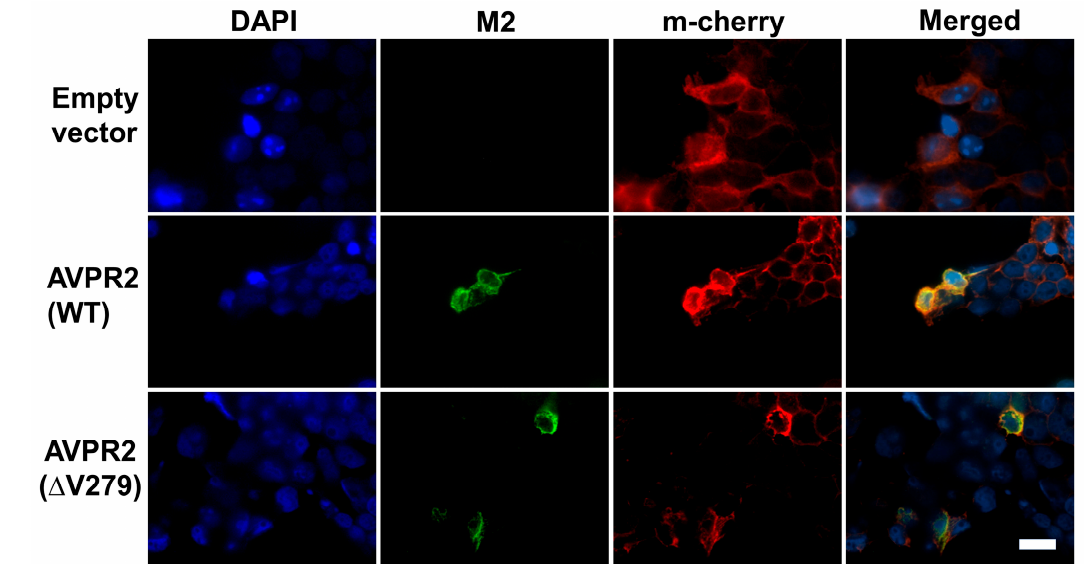
Figure 2. Arginine vasopressin receptor 2 (AVPR2)- ∆ V279 is localized in the membrane surface. The Flag-epitope tagged AVPR2 or AVPR2- ∆ V279 expression vector was co-transfected with a membrane-bound cherry fluorescent protein (m-Cherry) vector into HEK 293T cells. M2 antibody was used for immune-staining, and the locations of AVPR2 proteins were visualized by rhodamine-conjugated secondary antibodies. m-Cherry marked the plasma membrane are shown red, and the AVPR2 proteins are in green. Cell nuclei were counterstained by DAPI (blue). Both single staining and merged images are shown. Both the transfected wild-type and ∆ V279 mutant AVPR2 proteins were successfully expressed in HEK 293T cells, and both of the proteins can associate with the plasma membrane as indicated by m-cherry co-localization (yellow) in the merged images. The scale bar in the image represents 100 µ